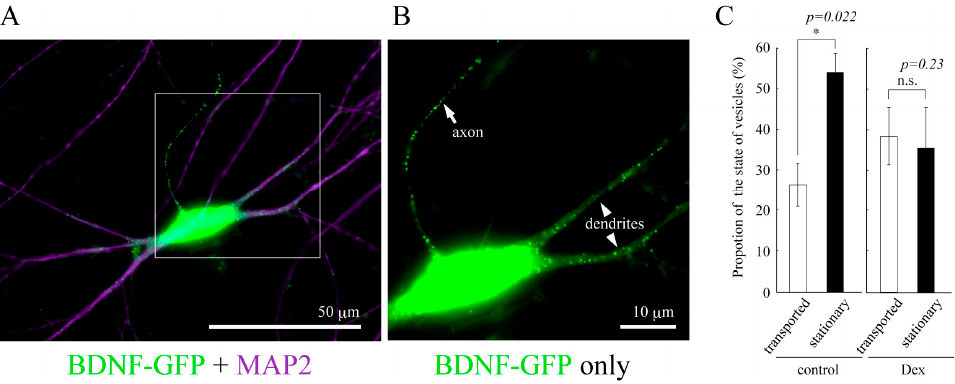
Figure 2. ( A ) Vesicular distribution of BDNF-GFP expressed in cultured cortical neuron obtained from rat brain (12 days in vitro). BDNF-containing vesicles are transported both in dendrites (MAP2-